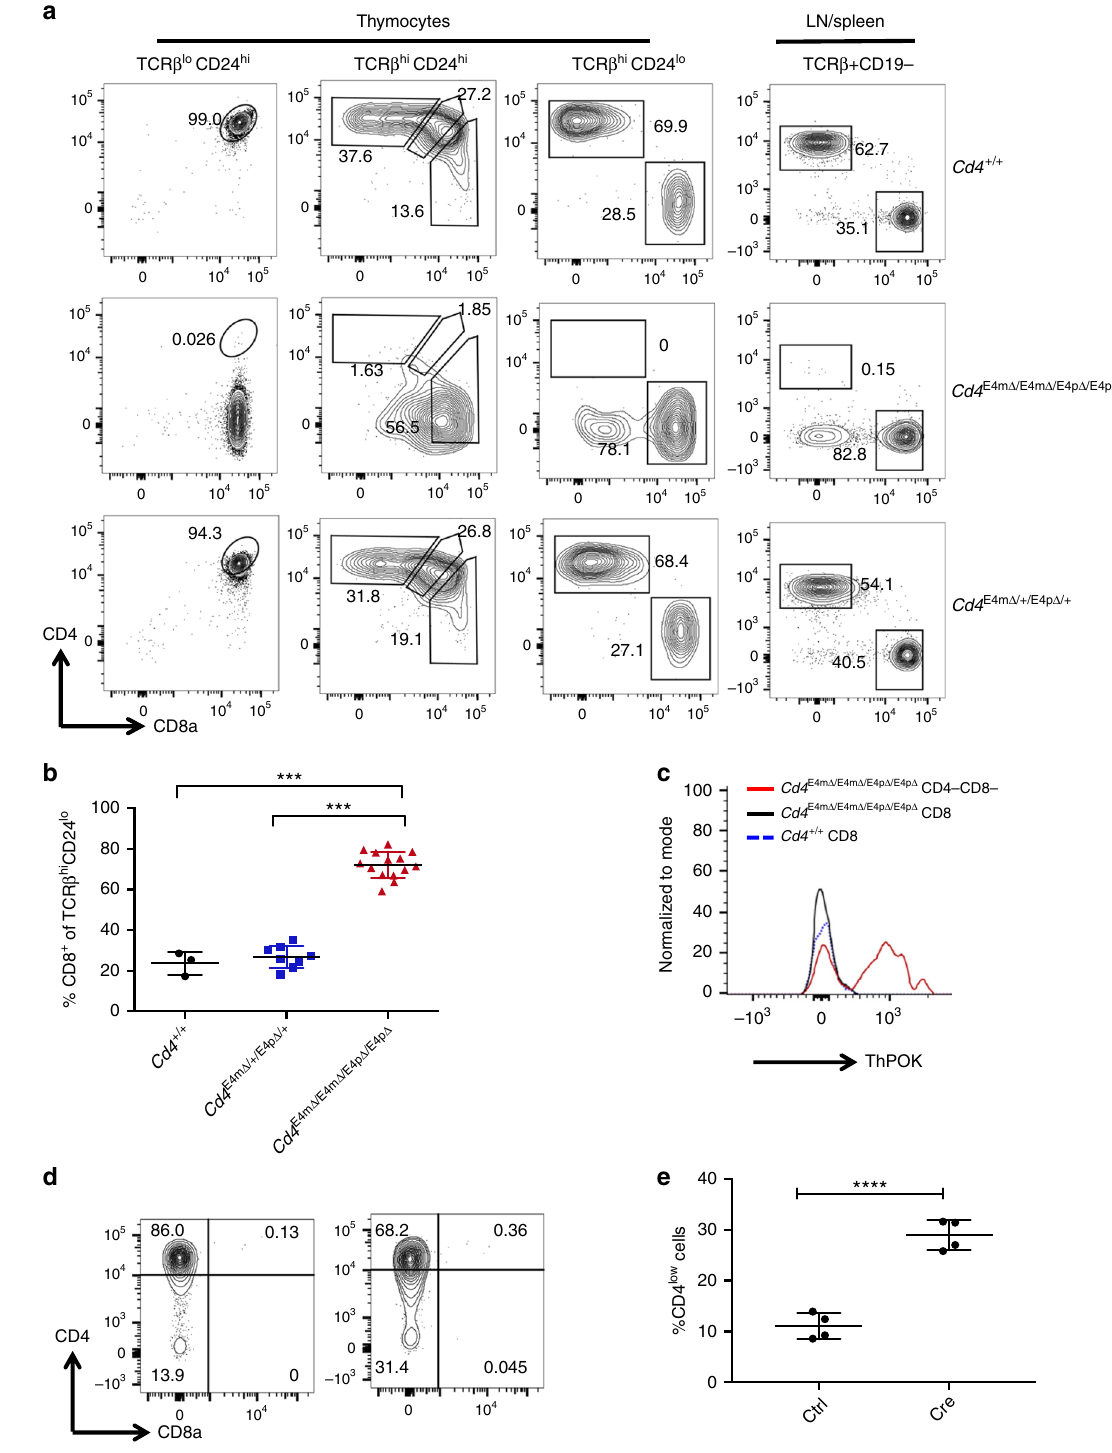
Fig. 2 E4m and E4p are partially redundant in regulating CD4 expression following positive selection. a CD4 and CD8 expression in indicated cell subsets and genotypes. Numbers in the FACS plot quadrants indicate cell percentages. Representative results of more than three independent analyses. b Proportions of CD8 SP cells among TCR β hi CD24 lo CD69 − thymocytes from mice with the indicated genotypes. Mean + SD. *** p < 0.001 (unpaired Student's t- test). c Flow cytometry analysis of ThPOK expression in thymocyte subsets from mice with indicated genotypes. Cells were gated on CD24 lo CD69 - TCR β hi prior to further gating based on CD8 expression. Data are representative of two independent experiments with multiple mice. d CD4 expression 5 days after in vitro activation and transduction of sorted naive CD4 + T cells from Cd4 E4m Δ /E4m Δ E4pFL/FL mice. Cells were sorted and transduced with retroviral MSCV-Cre-IRES-GFP or control vector. Cells were gated on GFP + transduced cells. Data are representative of two independent experiments with technical replicates. e Quanti fi cation of the percentage of cells that lost CD4 expression (CD4 low ) after activation and transduction with a retroviral MSCV-Cre-IRES-GFP or control vector. Mean + SD. *** p < 0.001(unpaired Student's t-